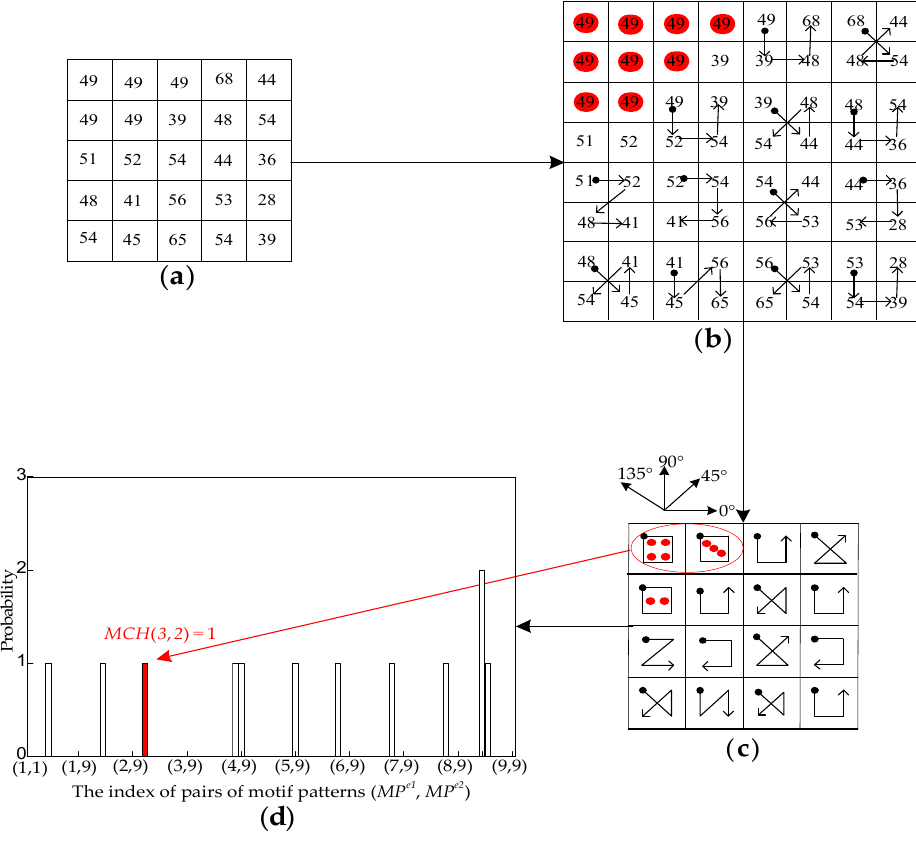
Figure 4. Schematic diagram of the motif co-occurrence histogram: ( a ) a 5 × 5 mini-numerical map; ( b ) the overlapping 2 × 2 grids of ( a ); ( c ) the motif map; and ( d ) the motif co-occurrence histogram.